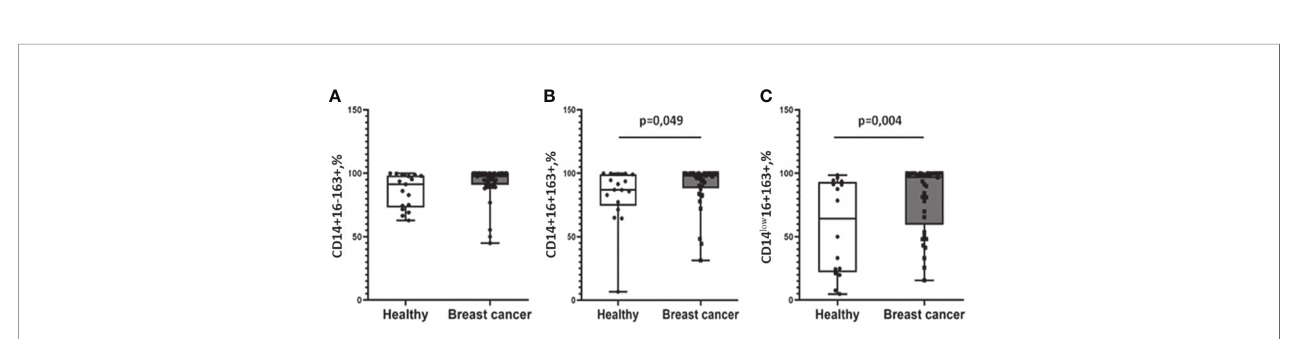
FIGURE 2 | Differential expression of CD163 on monocyte subpopulations in patients with breast cancer patients and healthy female individuals. No differences in CD14+16-163+ monocyte subset distribution (A) . Patients with breast cancer were characterized by a signi fi cantly higher percentage of CD14+16+163 (B) and CD14 low 16+163+ (C) subpopulations compared with healthy women. Patients with breast cancer n = 38; healthy female individuals n = 17. Statistical analysis was performed by the Wilcoxon test.